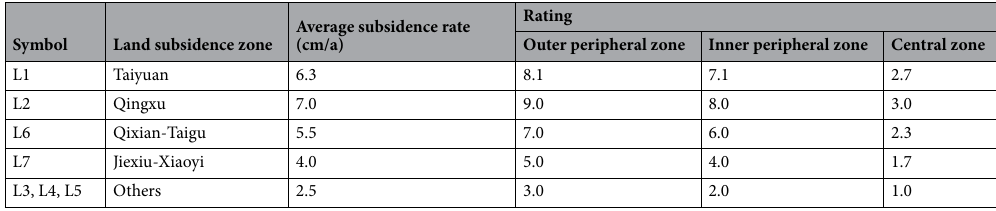
Table 5. Ratings of land subsidence zones (the average subsidence rate of the land subsidence zones are from the Geological Environment Monitoring Center of Shanxi Province, China).